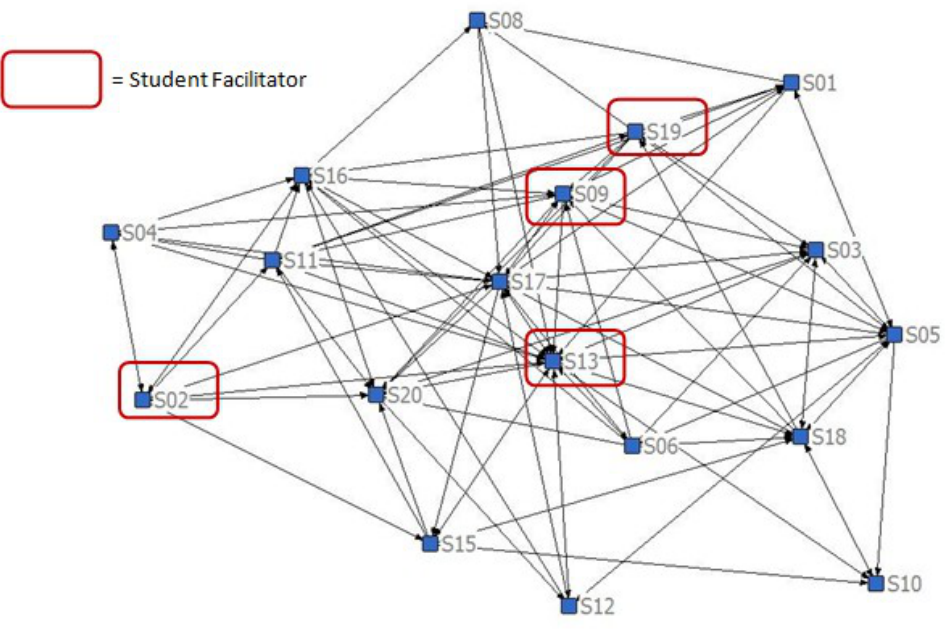
Figure 1 . Network graph for combined Module 6 discussions. Network positions of student